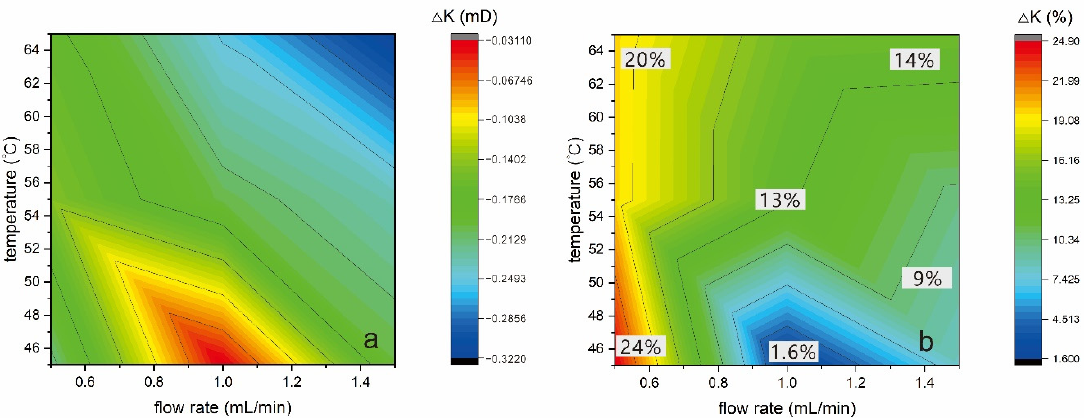
Figure 4. Contour plot of permeability variation for different temperatures and flow conditions. ( a ) Contour of permeability change values; ( b ) Percentage change in permeability after the experiment compared to the initial permeability. Note that all contour plots in this study are drawn using OriginPro 2022b and interpolated using the default algorithm, copyright © 1991–2022 OriginLab Corporation.